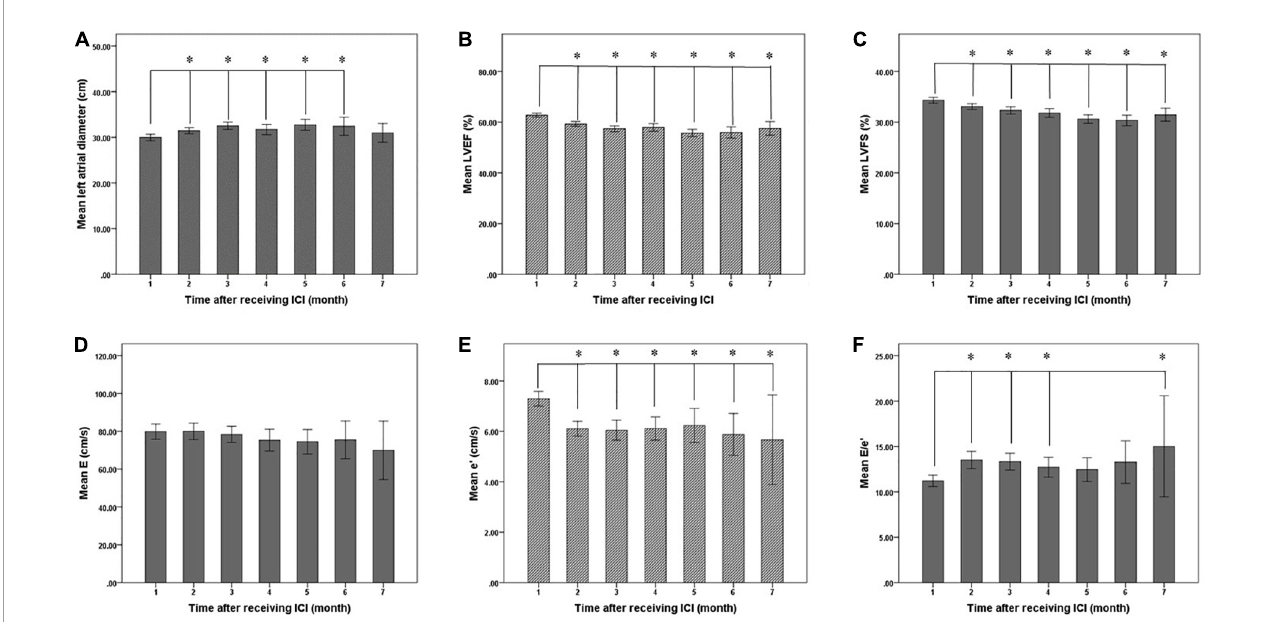
FIGURE6 Changes of left ventricular systolic and diastolic function before (1 month) and after immune checkpoint inhibitors (ICI) treatment. (A) Mean left atrial diameter of patients before and after ICI treatment, (B) mean LVEF of patients before and after ICI treatment, (C) mean LVFS of patients before and after ICI treatment, (D) mean E of patients before and after ICI treatment, (E) mean e’ of patients before and after ICI treatment, and (F) mean E/e’ of patients before and after ICI treatment. LVEF, left ventricular ejection fraction; LVFS, left ventricular fraction shortening; E, peak early diastolic mitral inflow velocity; e’, peak early diastolic mitral annulus velocity; E/e’, the ratio of E to e’. *Compared with baseline, the difference was statistically significant ( P < 0.05).